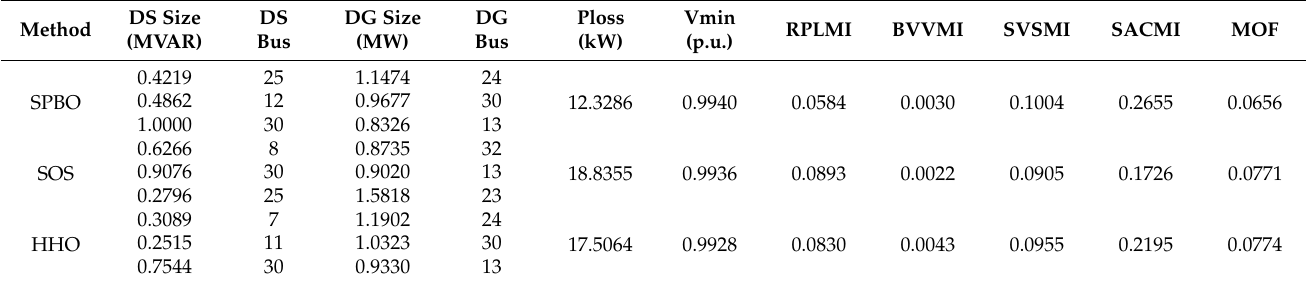
Figure 5. CC of optimization algorithms for case-4. ( a ) 33-bus test system; ( b ) 118-bus test system. Table 9. Comparison of results for simultaneous DS and PV-DG allocation (case-5) for 33-bus test